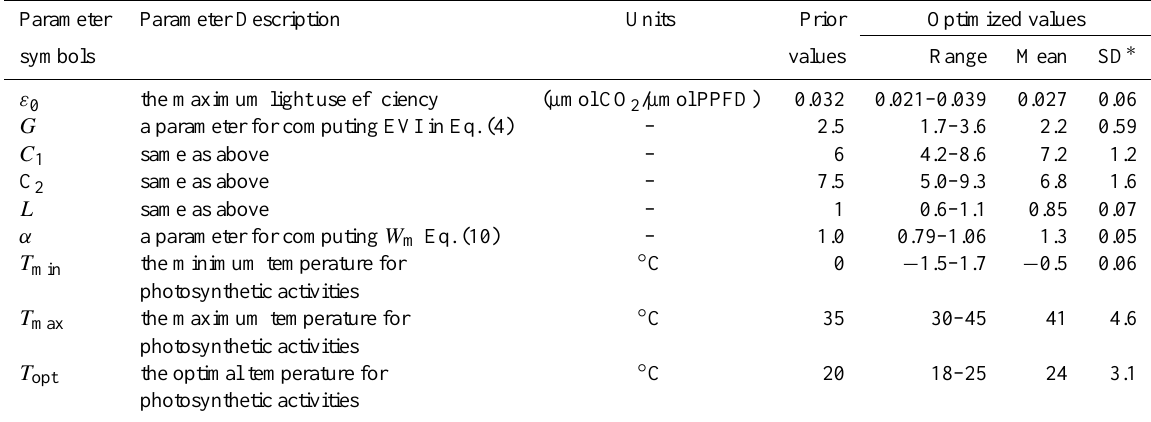
Table 3. Optimized VPM model parameters a subtropical plantation coniferous forest at QYZ, China. Parameter Parameter Description Units Prior